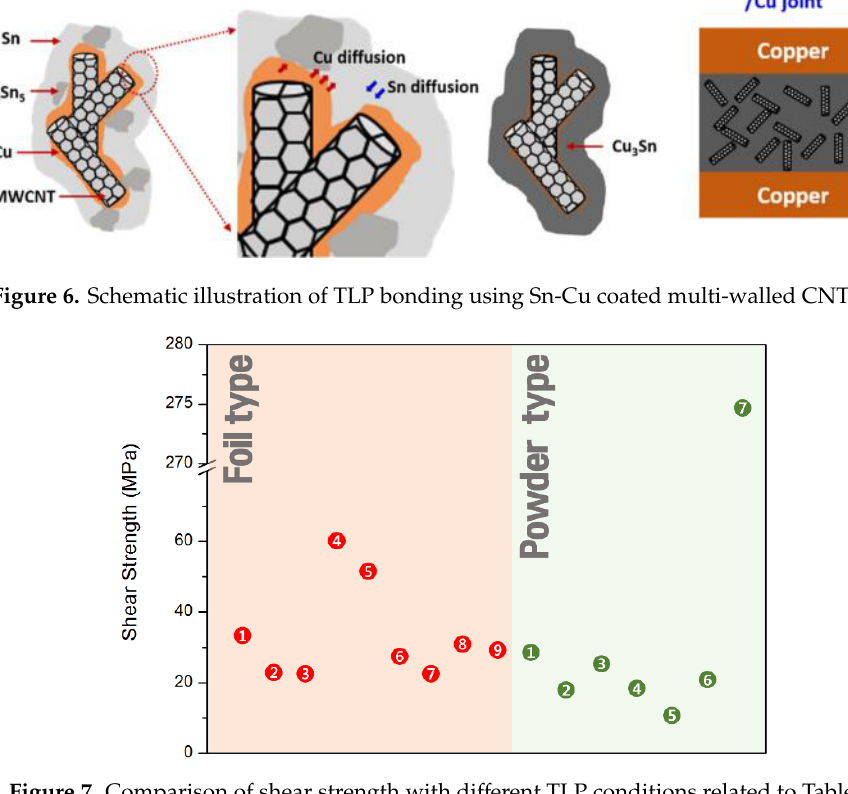
Figure 7. Comparison of shear strength with different TLP conditions related to Table 2.